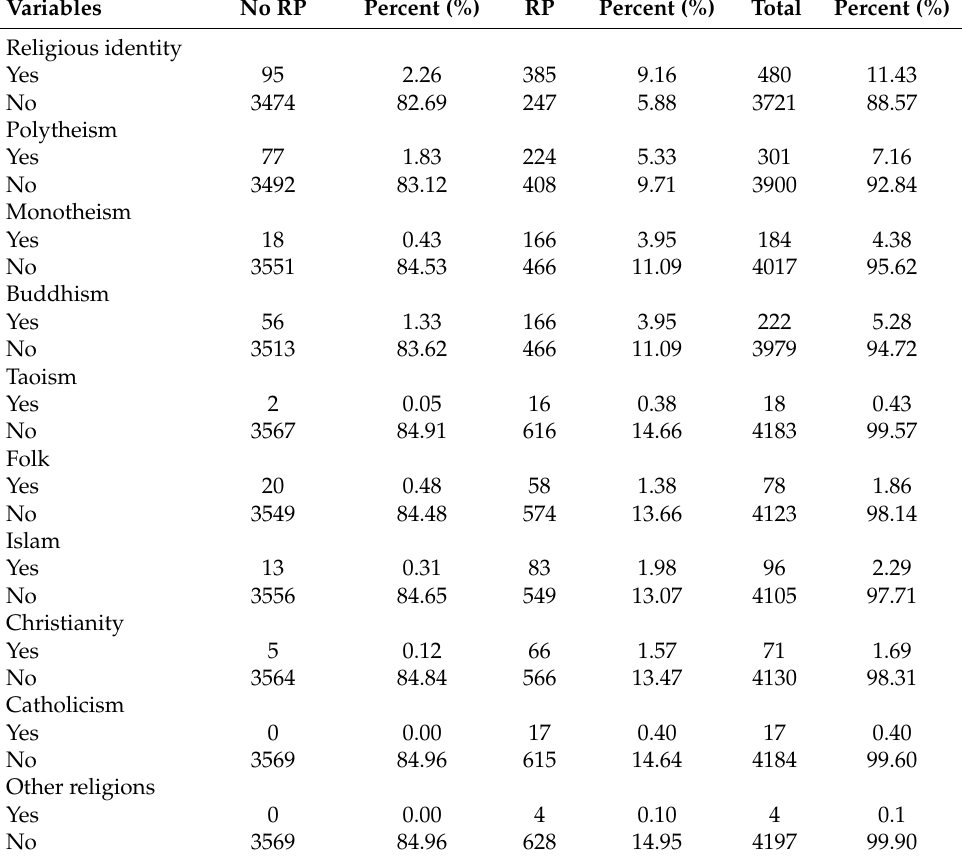
Table 2. The cross table of religious identities and religious practice ( N =